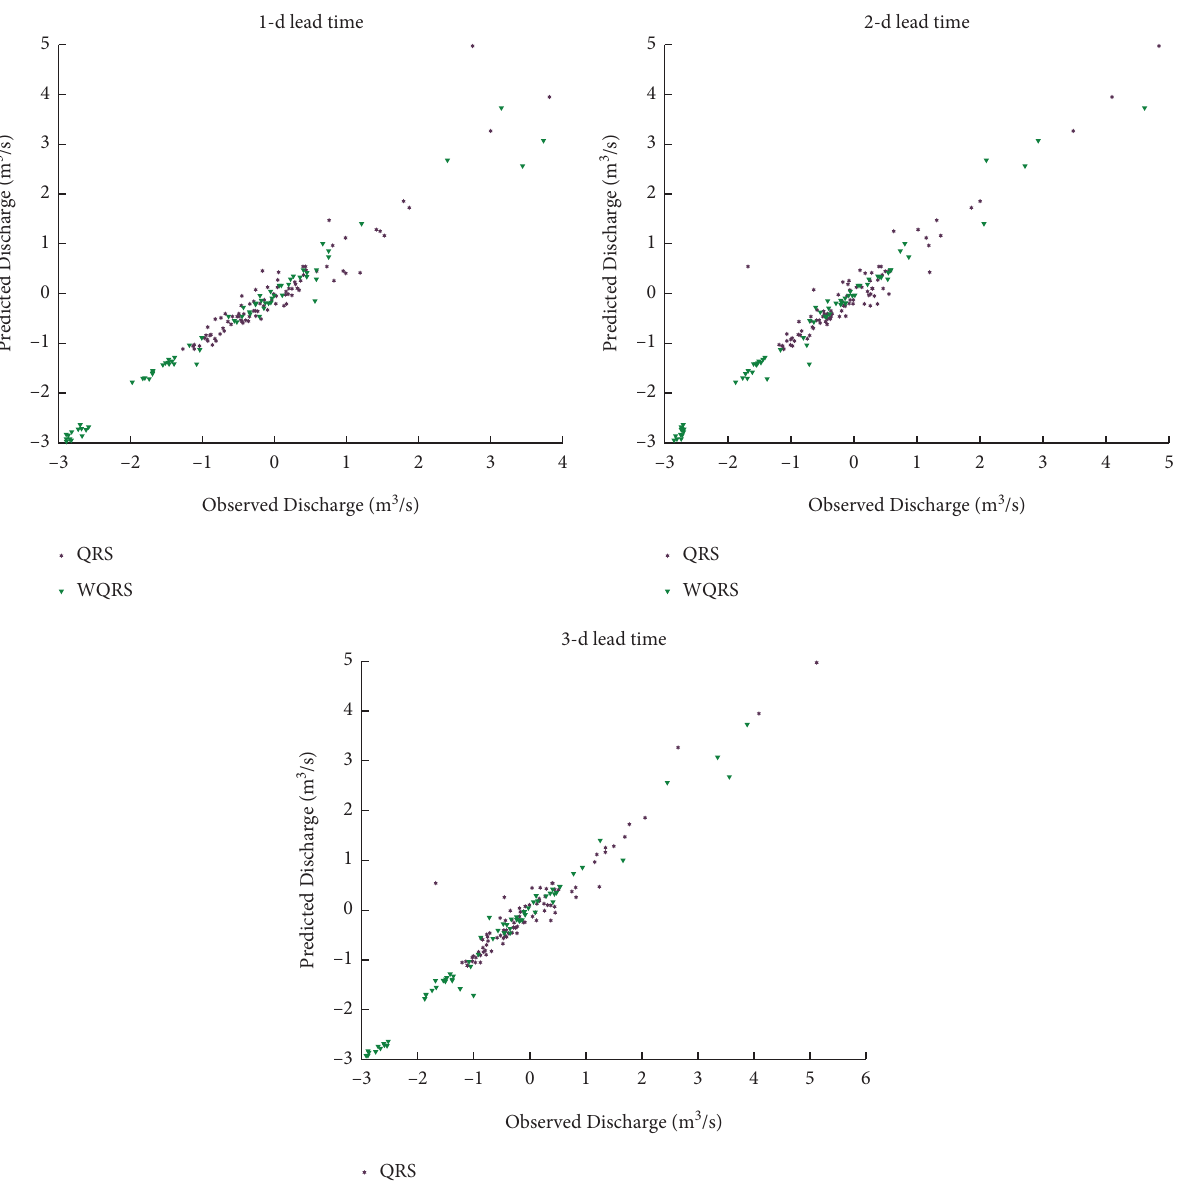
Figure 7: Represents scatter diagram of the observed reservoir fow against the predicted reservoir fow of QRS and WQRS